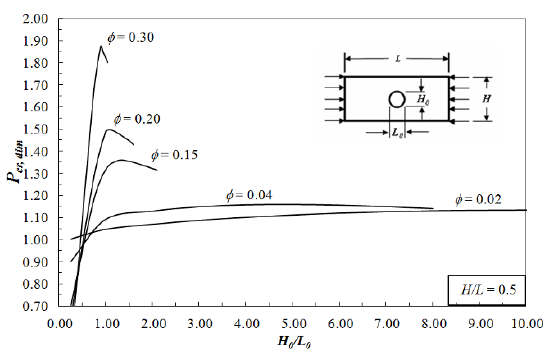
Figure 8. Plate with centered rectangular hole: optimization of the critical buckling load.